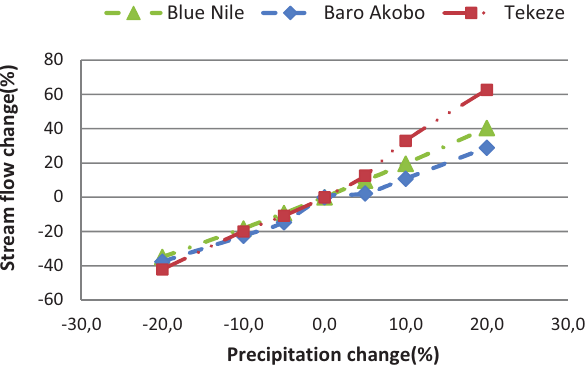
Fig. 8. Annual streamflow changes (%) to precipitation change (%) Figure 8: Annual streamflow changes (%) to precipitation change (%) holding temperature holding temperature fixed for the three basins. fixed for the three basins.